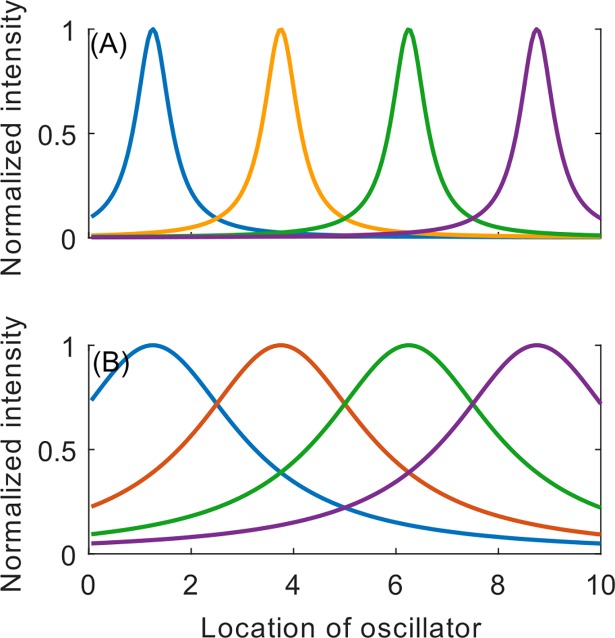
Spatial stimulation decay profile relative to locations of stimulation sites.Normalized intensity profiles as a function of location for (A) σ = 0.4 and (B) σ = 2. Stimulation sites correspond to the peaks of the spatial profiles. Oscillators are evenly distributed along the length of the horizontal axis.